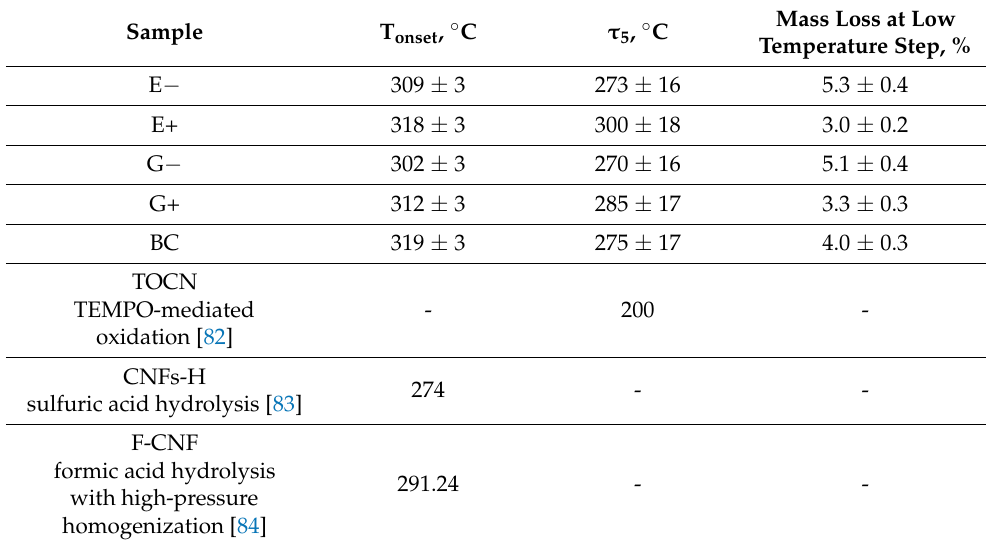
Figure 8. Dependences of weight loss (in %) and d ∆ m/dT on temperature of BC-NFs prepared under Table 2. Thermal properties of BC-NFs prepared under different conditions.